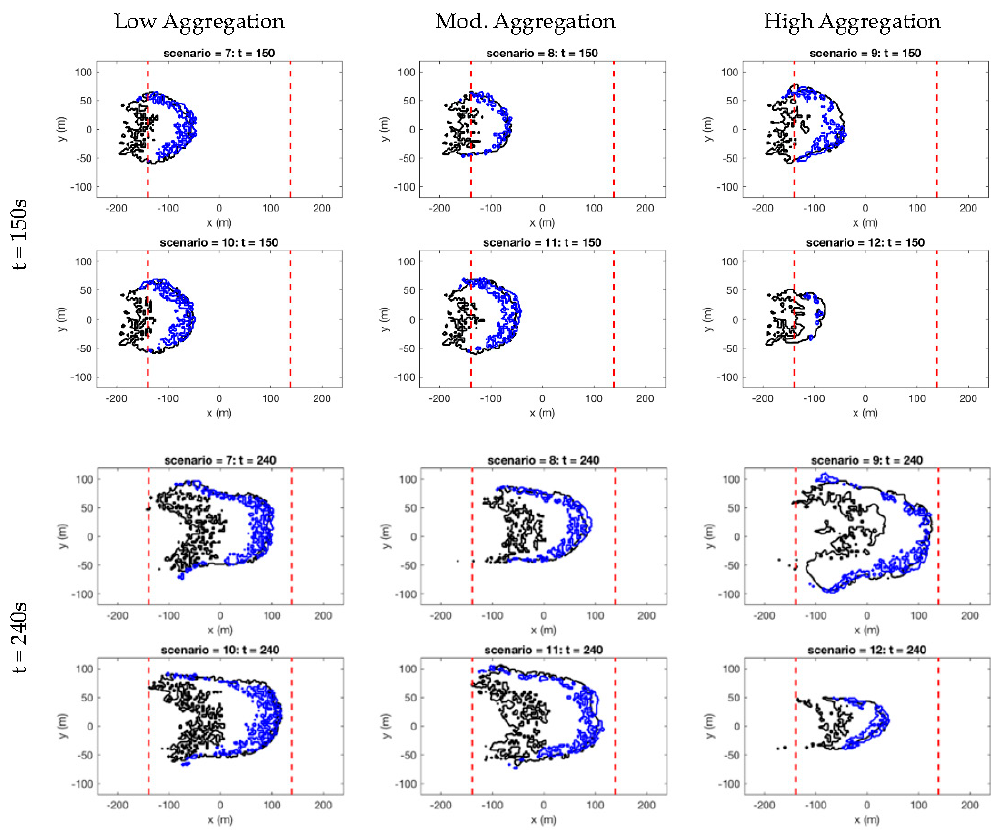
Figure 6. Fire progressions for high canopy cover, medium wind cases, at two points in time, t = 150 s (top two rows) and t = 240 s (bottom two rows). Black lines show contours of active surface fire while blue lines show concurrent contours of active fire in the canopy.